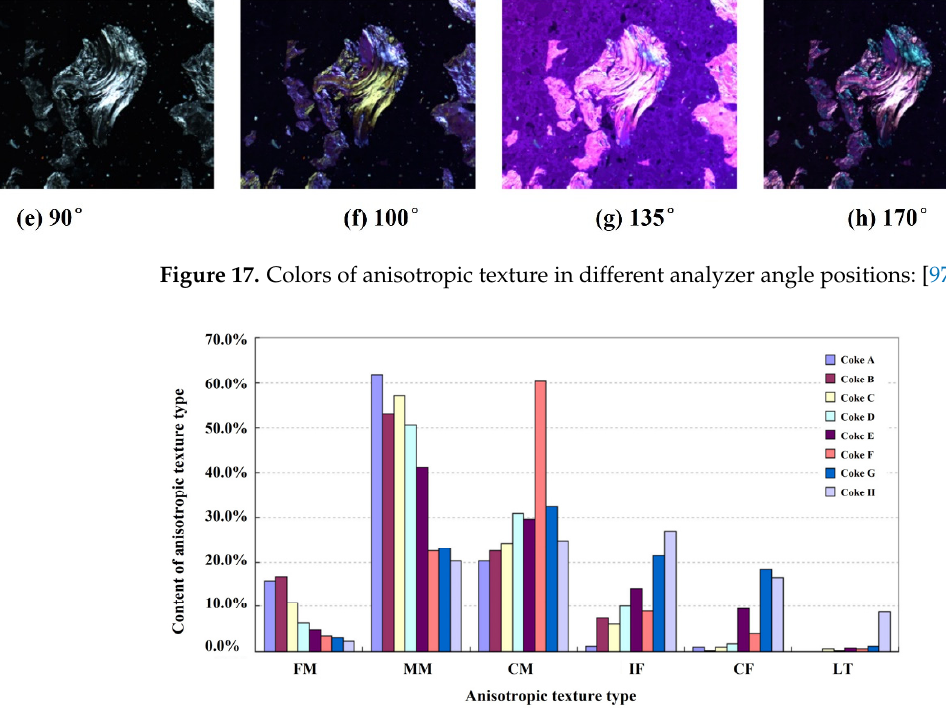
Figure 18. The contents of anisotropic texture types in eight cokes [97].